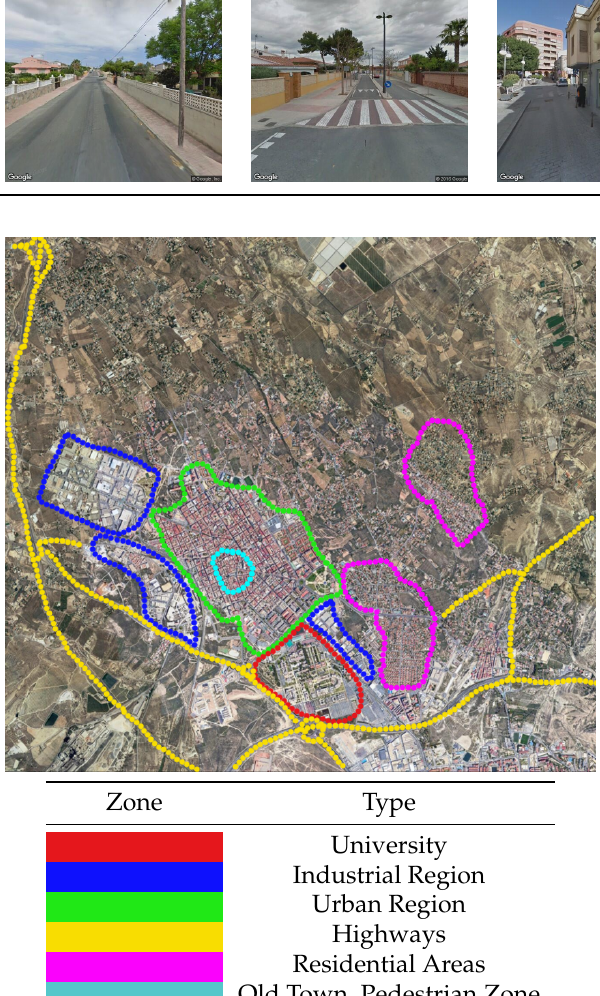
Figure 23. Ground truth for actual areas of the city selected for the